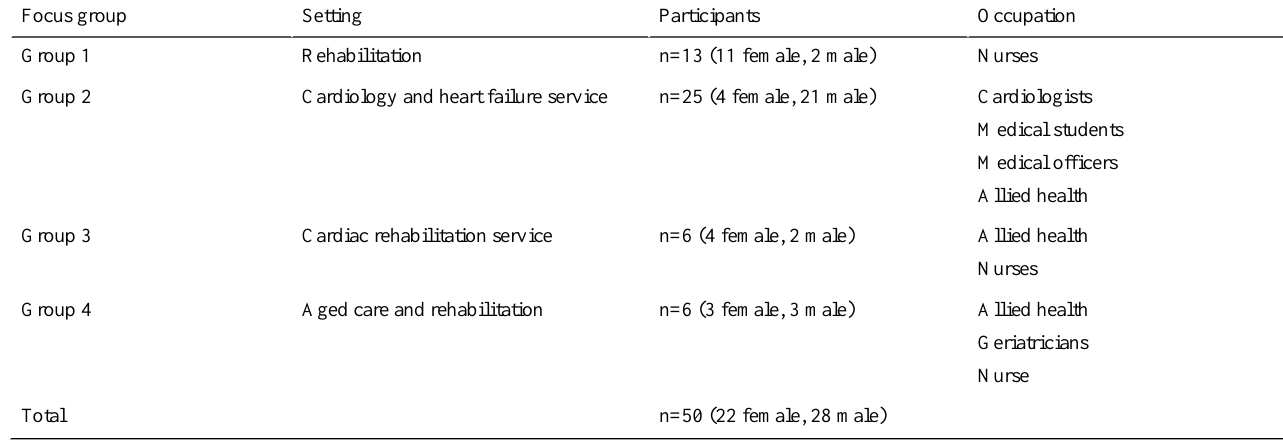
Table 1. Baseline demographics of